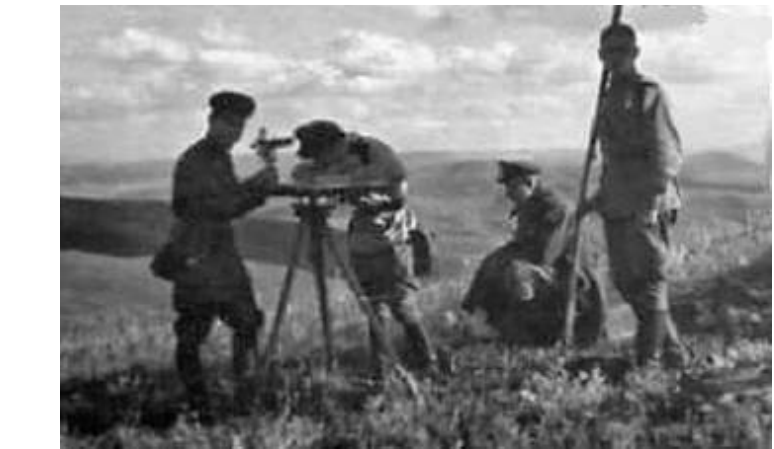
Figure 1 – Mapping the territory of Kazakhstan Рис . 1 – Картографирование территории Казахстана Слика 1 – Мапирање територије